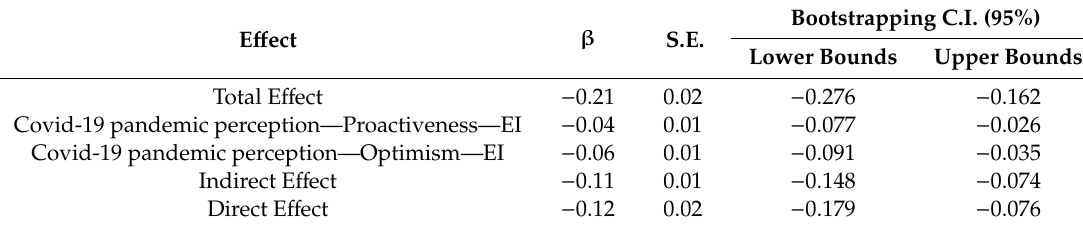
3. Total e ff ect, e ff ect, and perception—entrepreneurial intentions.